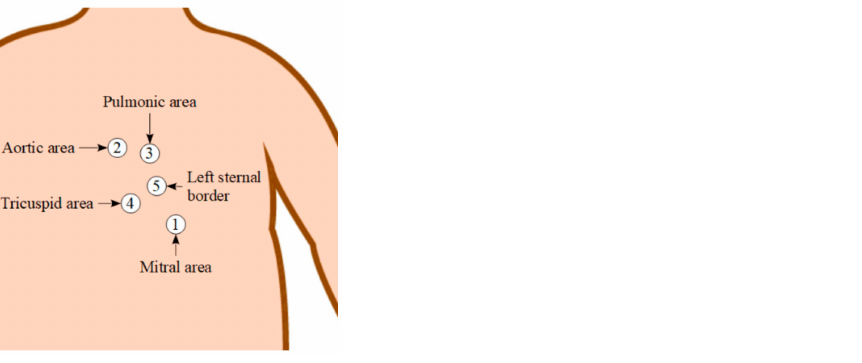
Figure 3. Approximate location, names, and chosen numeration of cardiac auscultation areas on the torso.